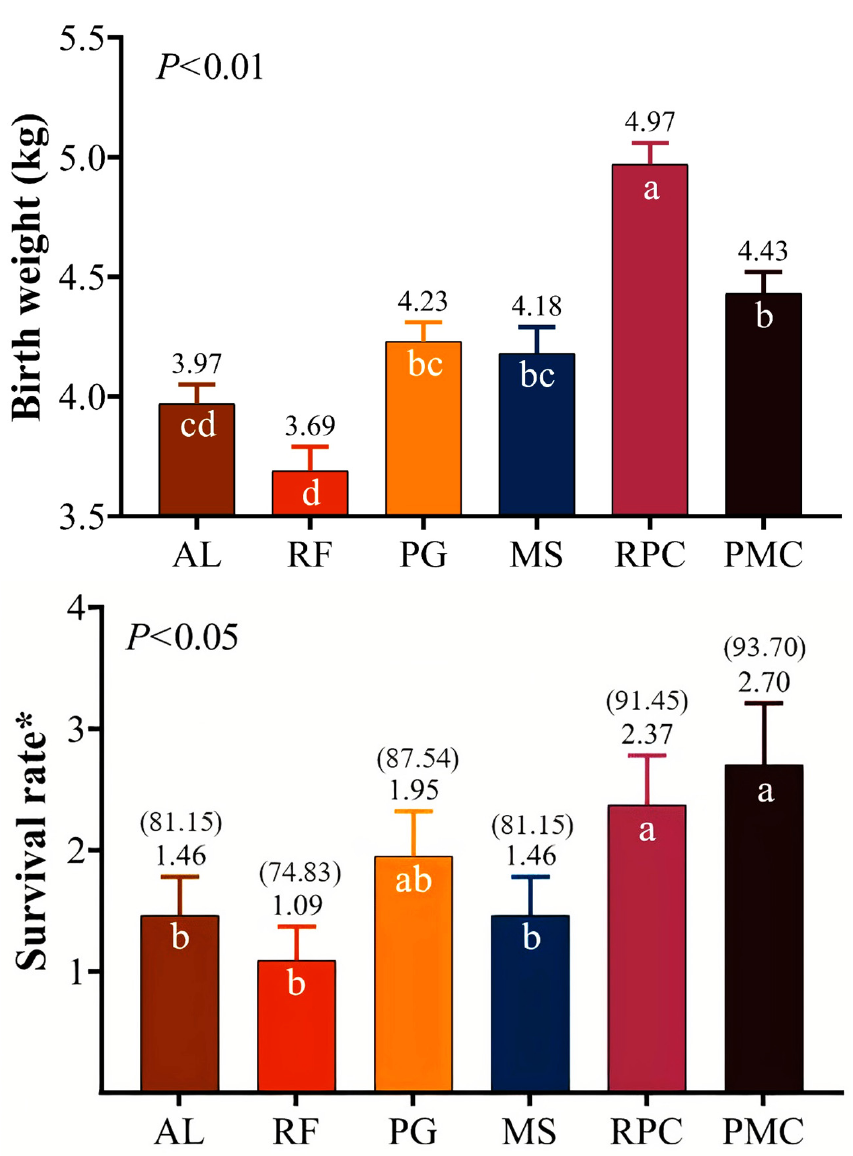
Figure 2. Effect of feed restriction and supplementation with propylene glycol, monensin sodium, and rumen-protected choline chloride in late pregnancy on birth weight (kg) and survival rate (%) of lambs. AL = ad libitum feed intake; RF = restricted feeding; PG = restricted feeding plus propylene glycol; MS = restricted feeding plus propylene glycol and monensin sodium; RPC = restricted feeding plus propylene glycol and rumen-protected choline chloride; PMC = restricted feeding plus propylene glycol, monensin sodium, and rumen-protected choline chloride. Values are means with their standard errors being shown by vertical bars. Means with different letters indicate significant differences among treatments. * Data are shown as logit values in columns and back-transformed percentages in parentheses.